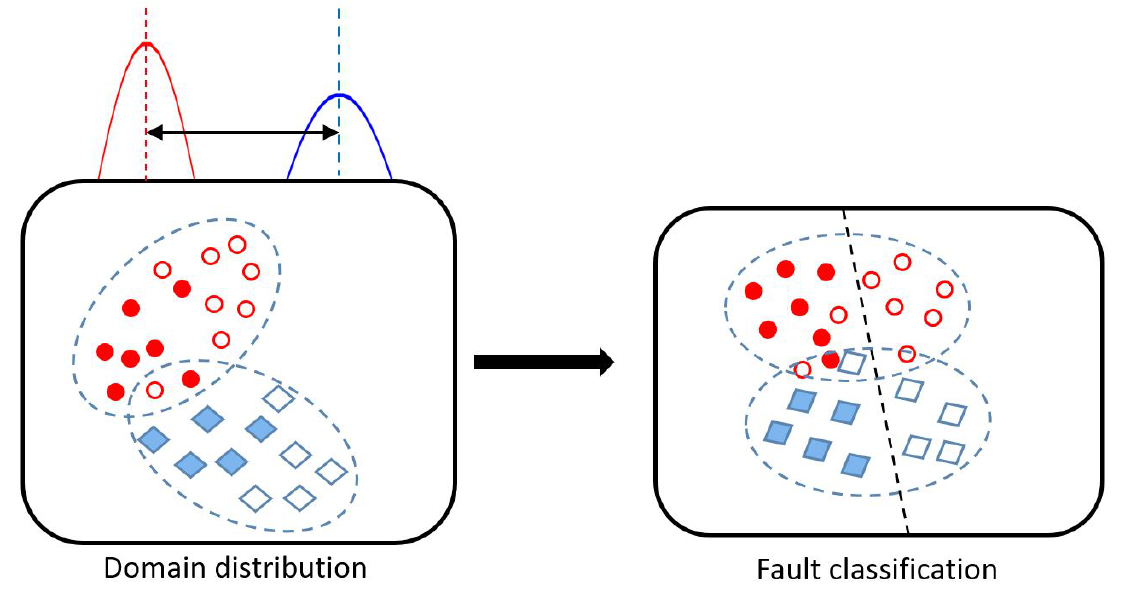
Figure 2. Spatial distribution of data points outlier and latent representation